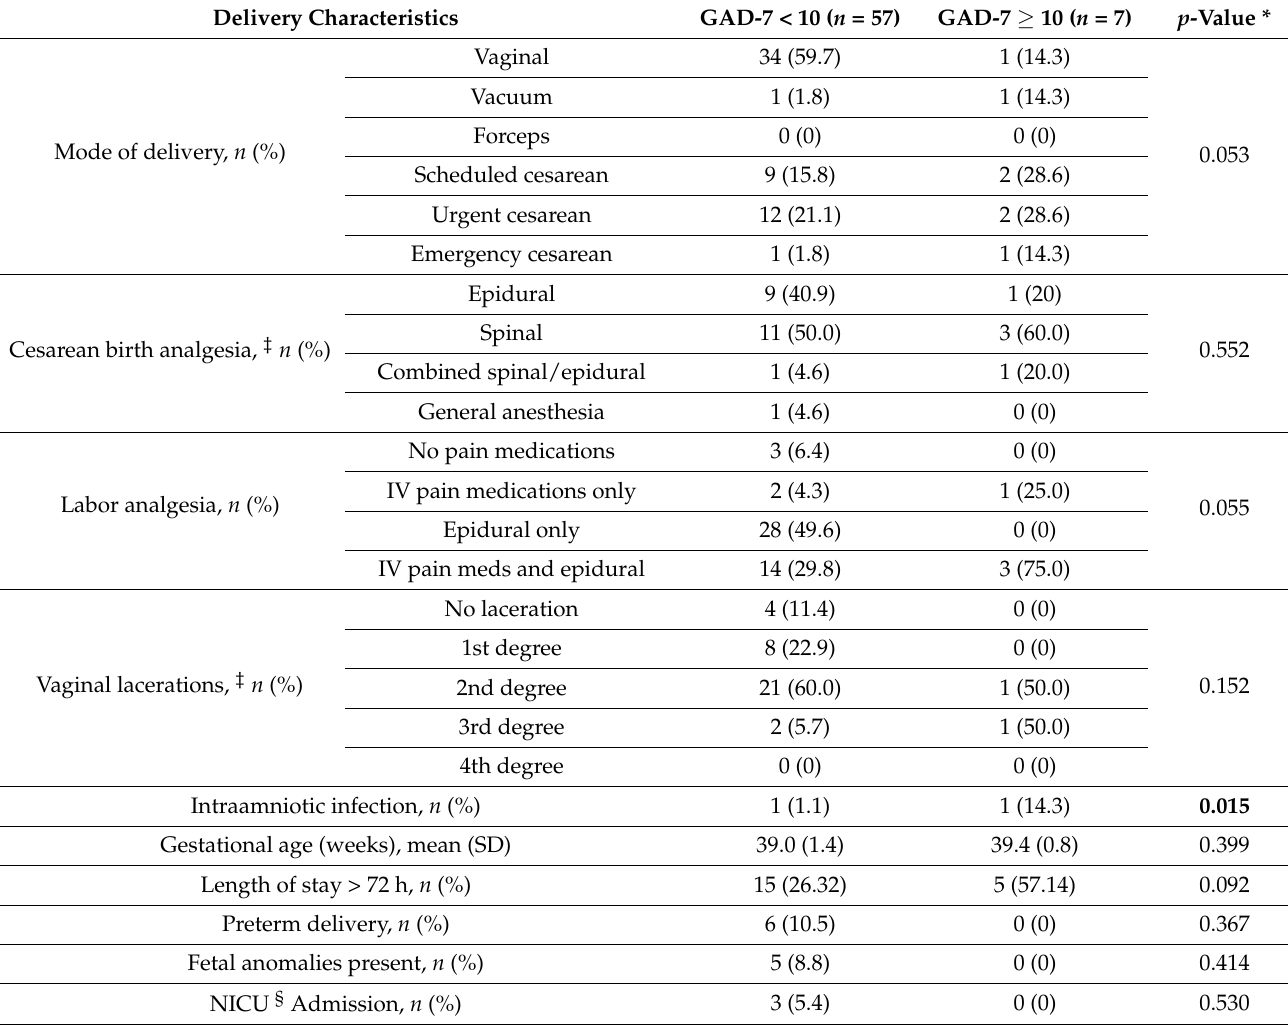
Table 2. Delivery Characteristics.